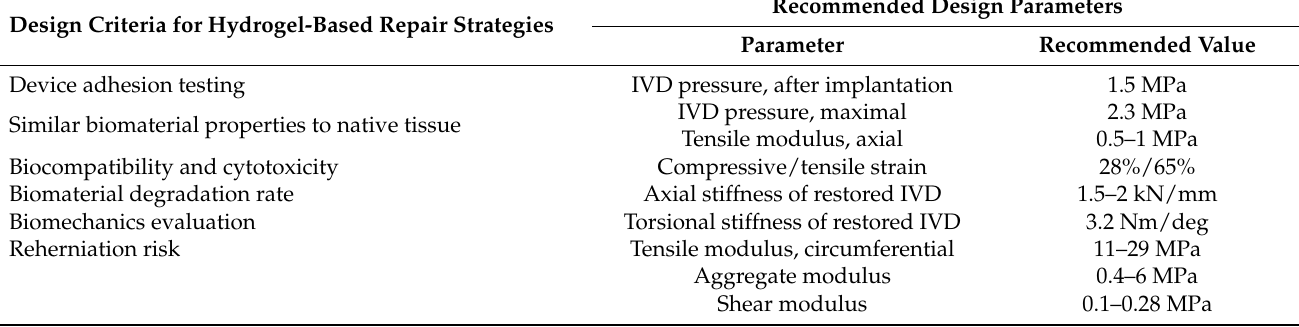
Table 1. Suggested design criteria for a hydrogel-based strategy and recommended values from Long et al.